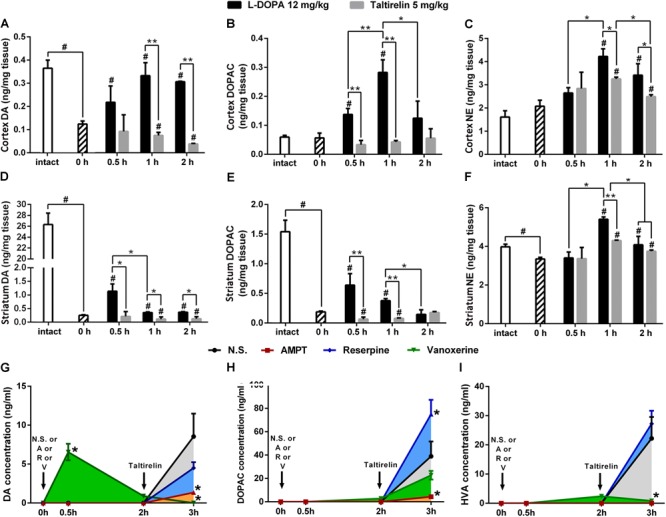
Taltirelin elevated dopamine level in a DA-releasing dependent manner. (A–F) The high performance liquid chromatography coupled with electrochemical detection (HPLC-ECD) assessed the intracellular dopamine (DA), 3,4-dihydroxyphenylacetic acid (DOPAC) and norepinephrine (NE) in the cortex and striatum of 6-OHDA lesioned animals treated with L-DOPA or Taltirelin. #p < 0.05 vs. 0 h, ∗p < 0.05 vs. indicated group, ∗∗p < 0.05 vs. indicated group. (G–I) Effects of AMPT (250 mg/kg, i.p.), reserpine (5 mg/kg, i.p.) or vanoxerine dihydrochloride (20 mg/kg, i.p.) on Taltirelin-induced alterations of DA, its metabolites DOPAC and HVA in dialysates collected from lesioned DLS. Taltirelin (5 mg/kg) was injected 2 h after administration of three medications. ∗p < 0.05 vs. other groups at the same time point. N = 3. Error bars represent SEM.